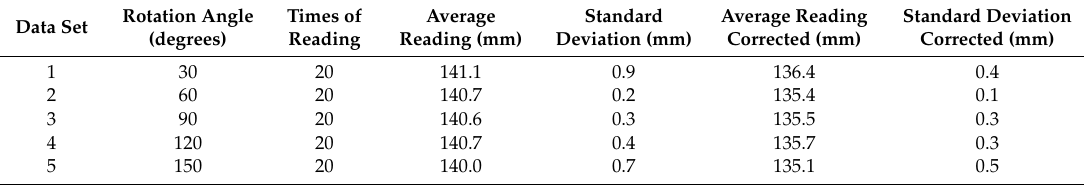
Table 6. Height reading stability analysis when the camera lens is